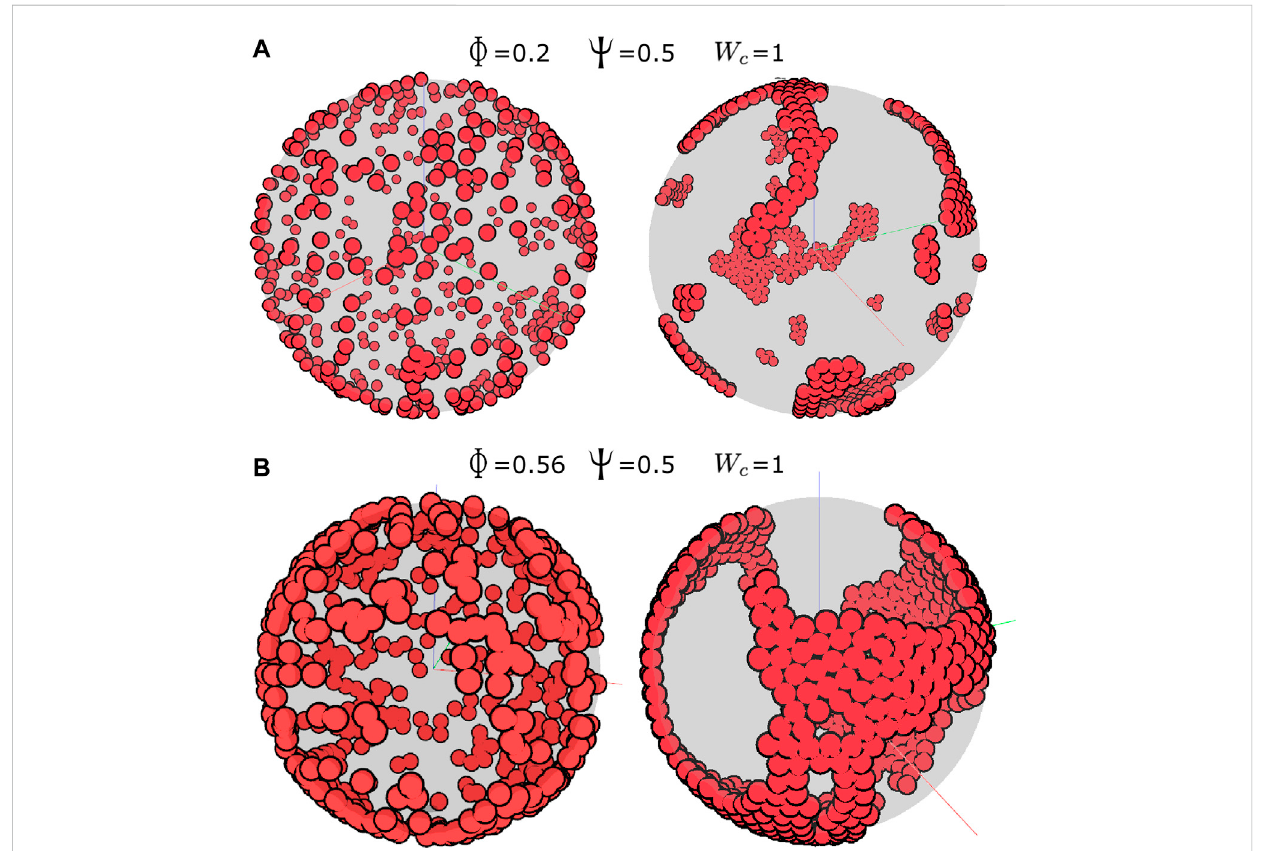
FIGURE 3 Aggregation inthecell-autonomoussystem. (A) Celldensity ϕ (cid:1) 0 . 2(500cellsonasphereofradius25), ψ (cid:1) 0 . 5,and W c (cid:1) 1. (B) Celldensity ϕ (cid:1) 0 . 56 (500 cells on a sphere of radius 15), ψ (cid:1) 0 . 5, and W c (cid:1) 1. The images on the left show the initial conditions, and the images on the right show the simulations after 500 time steps. The YSL is drawn as a transparent gray sphere; hence, the cells on the far side appear darker. The three-dimensional perspective means that these cells also appear